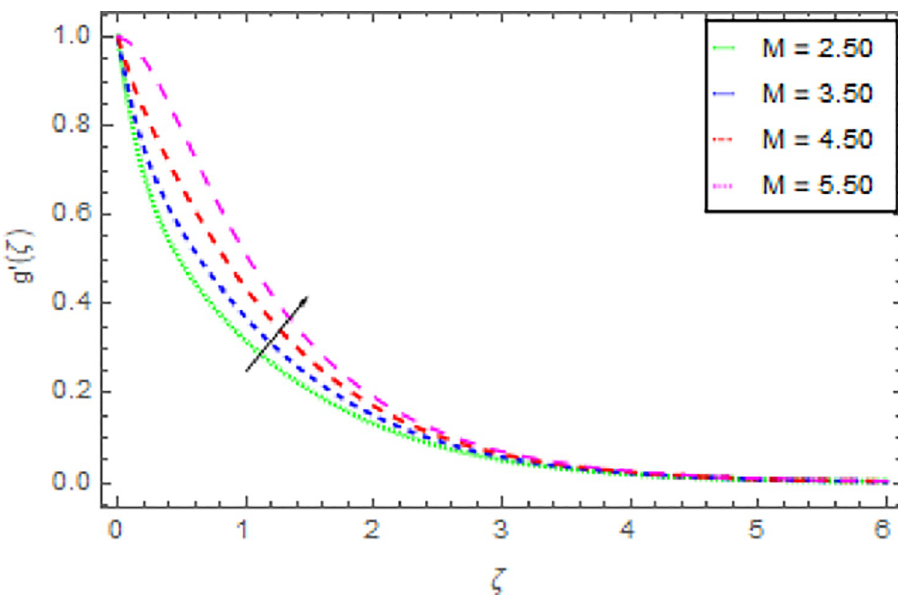
Fig 6. Deviation in nanofluid velocity ( y − direction) against M when Pr = 1000, m = 0.10, n = 1.00, δ = 0.40, β = 1.00, Nr = 0.20 and ϕ = 0.01 to ϕ = 0.04.